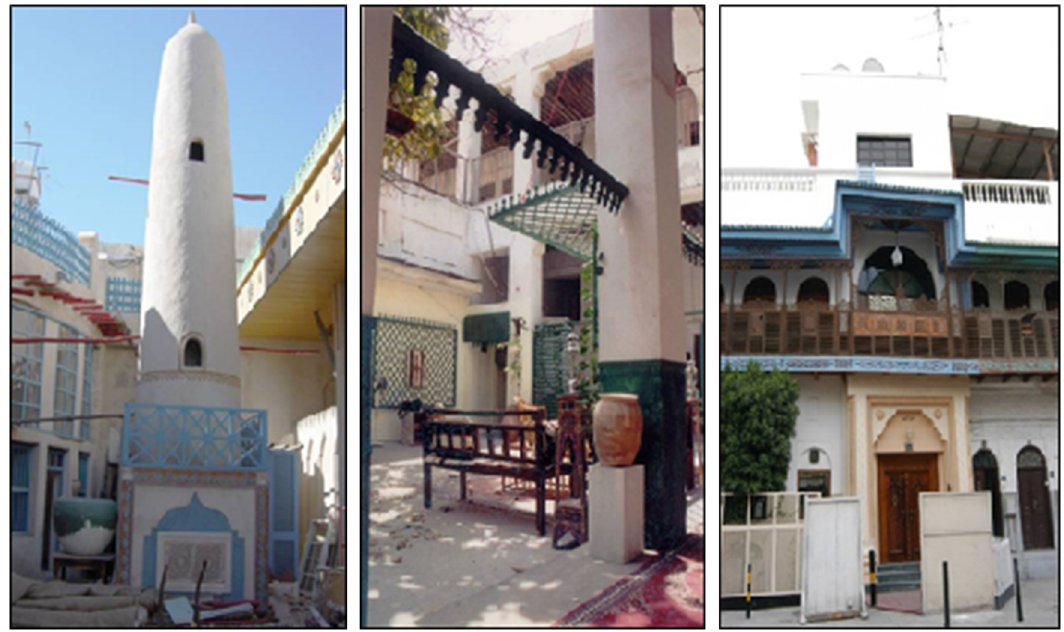
Fig. 7. Good examples of preserving traditional buildings by private sector initiatives. Source: Photos taken by the Author,